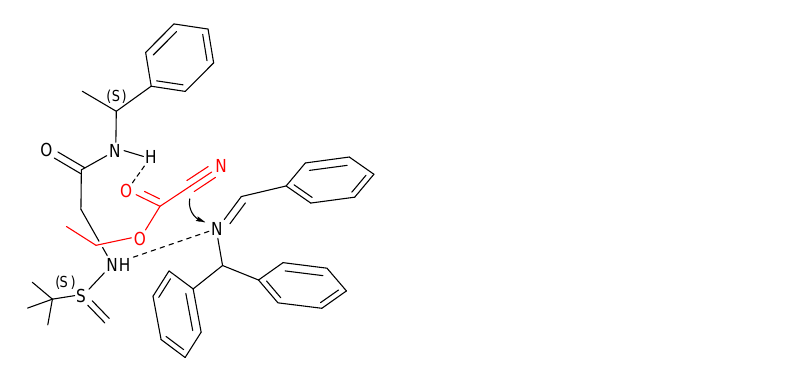
Scheme 32. Strecker reaction of N-benzhydryl- and N-tosyl-substituted imines.